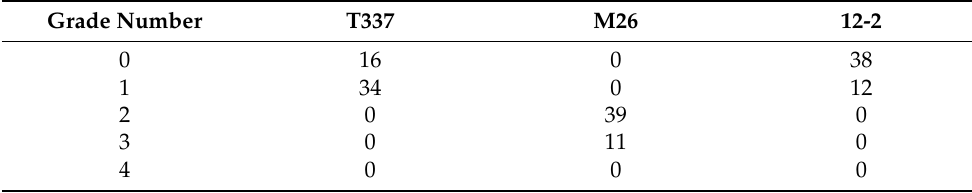
Table 1. The number of plants of the three rootstocks in each grade 7 days after MR5 infection.